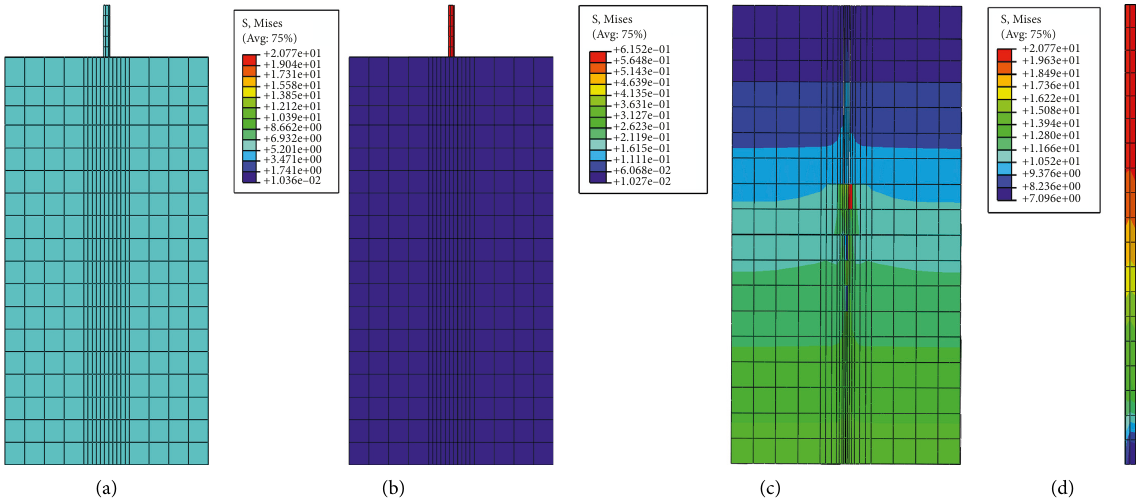
Figure 4: Single pile model: (a) mesh subdivision; (b) overall stress nephogram; (c) soil stress nephogram; (d) pile stress nephogram.